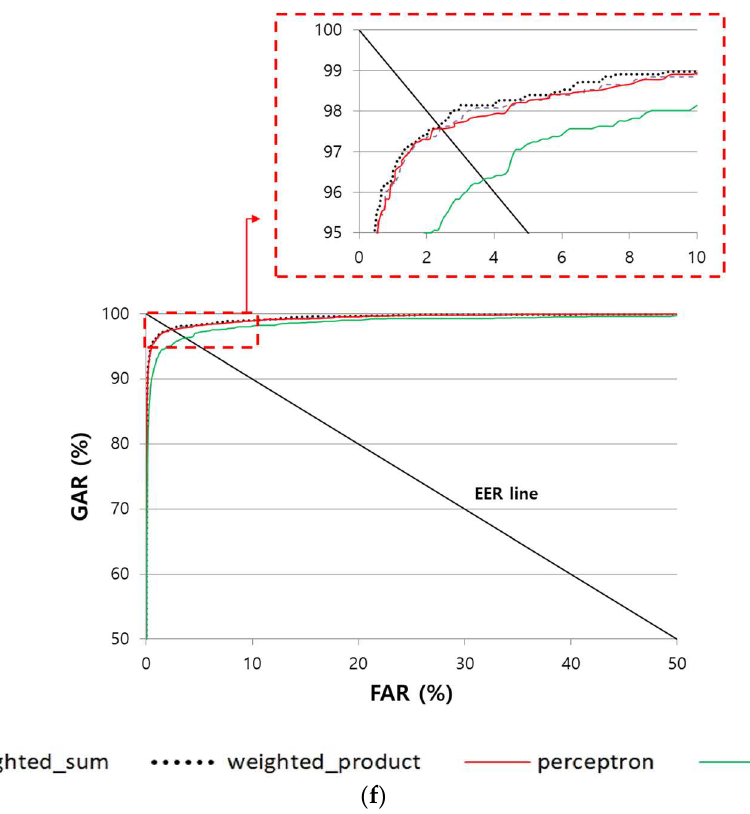
Figure 12. Comparison of ROC curves of multimodal recognition according to various score-level fusions in the case using ( a ) ResNet-50 with SDU-DB, ( b ) ResNet-50 with PolyU-DB, ( c ) ResNet-101 with SDU-DB, ( d ) ResNet-101 with PolyU-DB, ( e ) VGG Net-16 with SDU-DB, and ( f ) VGG Net-16 with PolyU-DB. Table 8. Comparison of the accuracy of multimodal recognition according to various score-level fusion methods (unit: %).